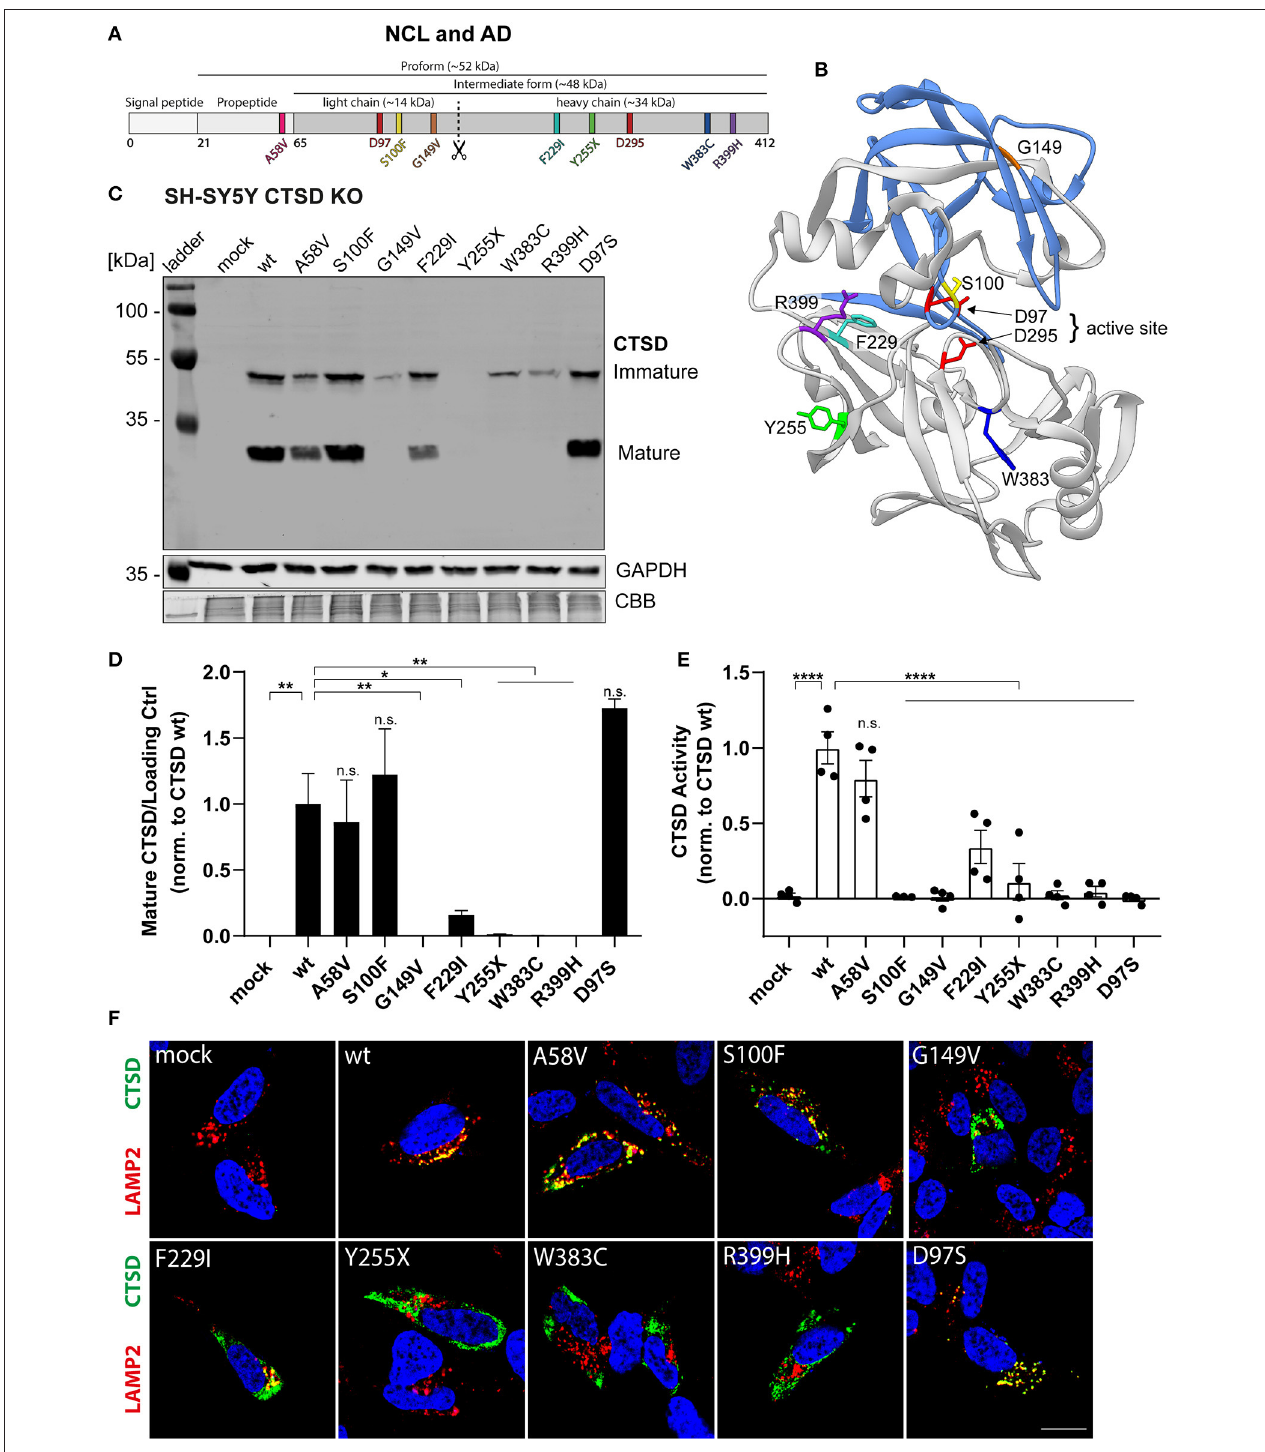
FIGURE 1 | Characterization of CTSD variants associated with neurodegenerative diseases in SH-SY5Y CTSD KO cells. (A) Schematic overview of NCL- and AD-associated CTSD variants analyzed in this study. During protein maturation, the signal peptide (20 aa) and the propeptide (44 aa) are removed, generating an intermediate form ( ∼ 48 kDa) that is further processed in the lysosome into a double-chain mature form comprised of a light chain ( ∼ 14 kDa) and a heavy chain ( ∼ 34 kDa; symbolized by scissor symbol). Both chains remain associated by hydrophobic interactions. Point mutations found in NCL- and AD- patients located within different protein parts are shown in different colors (A58V, pink, propeptide; S100F, yellow, light chain; G149V, orange, light chain; F229I, light blue, heavy chain; Y255X, green, heavy chain; W383C, dark blue, heavy chain; R399H, purple, heavy chain). Aspartates D97 and D295 as part the catalytic site are highlighted